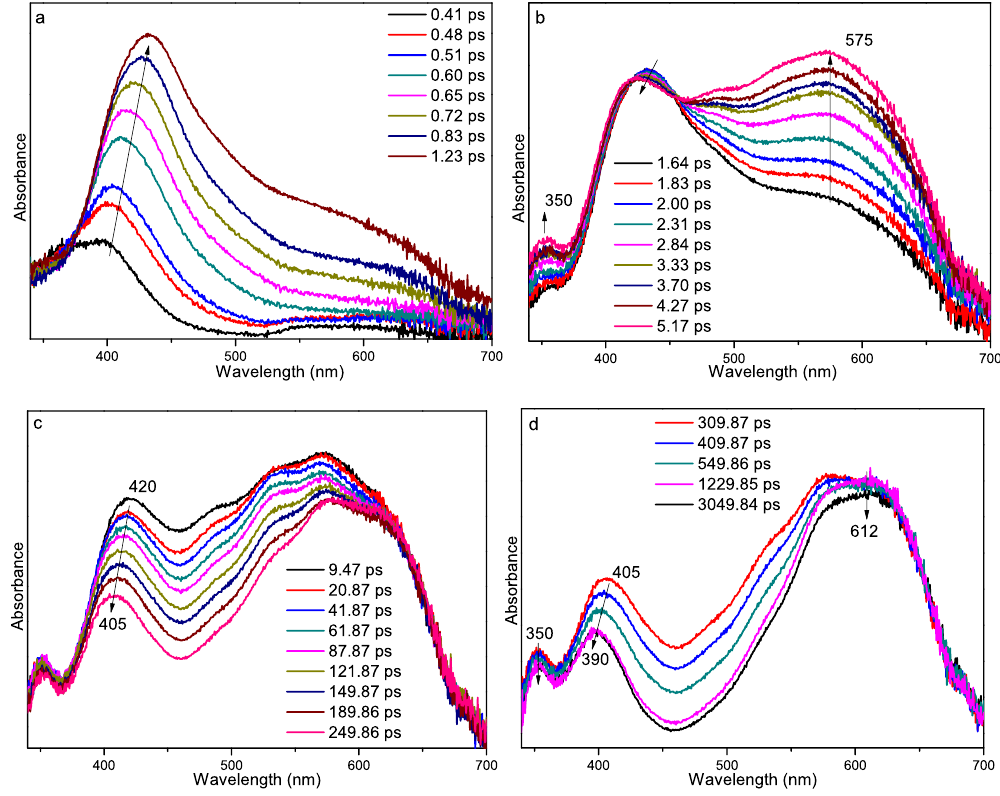
Figure 9. The fs-TA spectra of PPAQ in pH 2 MeCN-H 2 O (1:1) at different delay times recorded under 266 nm excitation are shown.